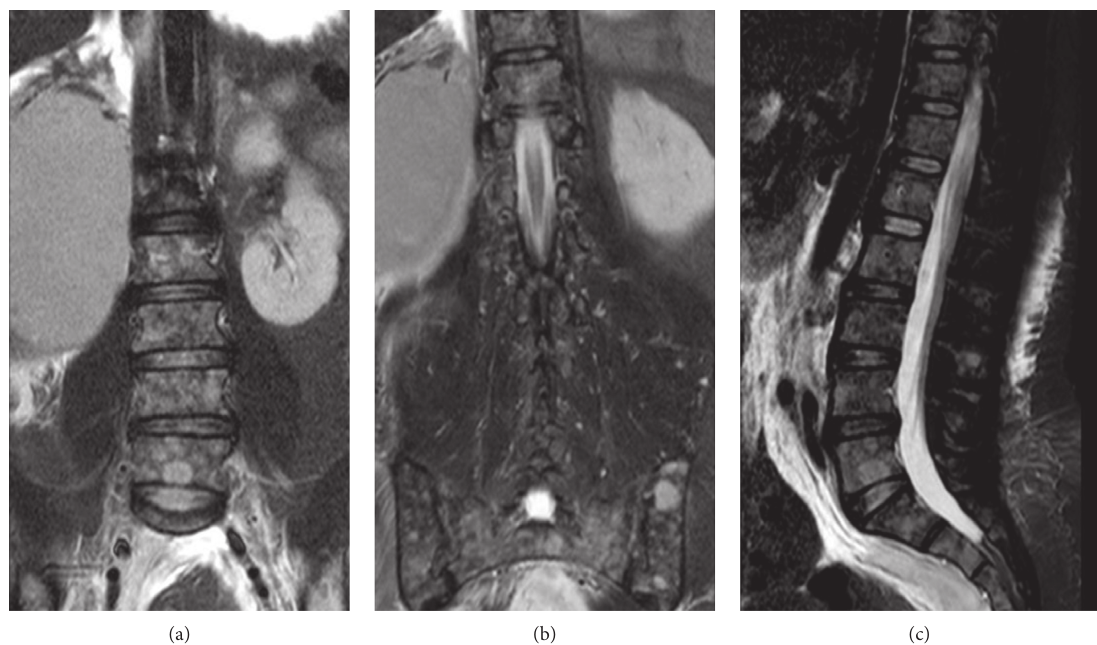
Figure 3: Magnetic resonance images enhanced in short inversion time inversion recovery (STIR) in coronal (left and middle) and sagittal (right). The alteration in the signal of the bone marrow of the vertebral bodies and both iliac bones can be seen by countless discrete images with hyperintense signals of contours, rounded, diameters of up to 13 mm, which are compatible diffuse commitment by multiple myeloma. In addition, the asymmetry in the size of both kidneys can be observed. The adequate attention in a lesion suggestive of